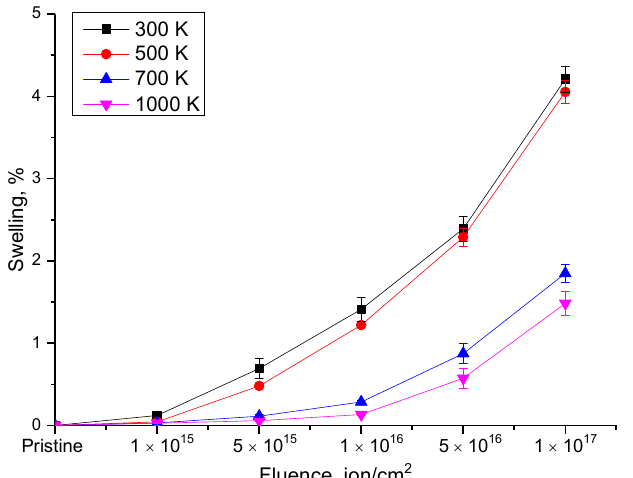
Figure 5. Results of the change in the crystal lattice swelling value depending on the fluence and irradiation temperature.